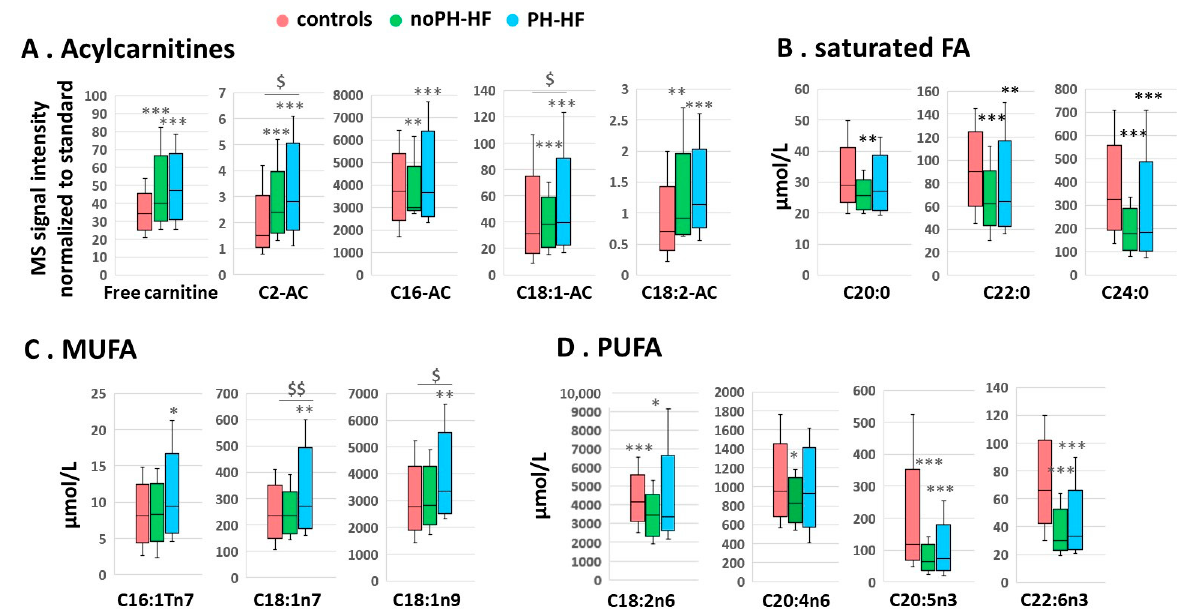
Figure 2. Acylcarnitines and fatty acids circulating levels are differentially affected in PH-HF ( n = 33) and noPH-HF (N = 27) compared to controls (N = 72). Box plots represent top discriminant FA-related metabolites identified using the PCA analysis in the comparison noPH-HF (green) vs. controls (red) and PH-HF (blue) vs. controls. Shown are semi-quantitative analyses of ( A ) acylcarnitines reported as MS signal ratio normalized to standard, and the quantitative analysis of ( B ) saturated FA, ( C ) MUFA, and ( D ) PUFA. In the boxplots, rectangles represent the SD, the segment inside the rectangle the median and the whiskers above and below the maximum and minimum. * p < 0.05, ** p < 0.01, *** p < 0.001 compared to controls; $ p < 0.05, $$ p < 0.01 PH-HF vs. noPH-HF. Other more commonly measured metabolites are shown in Figure S1.